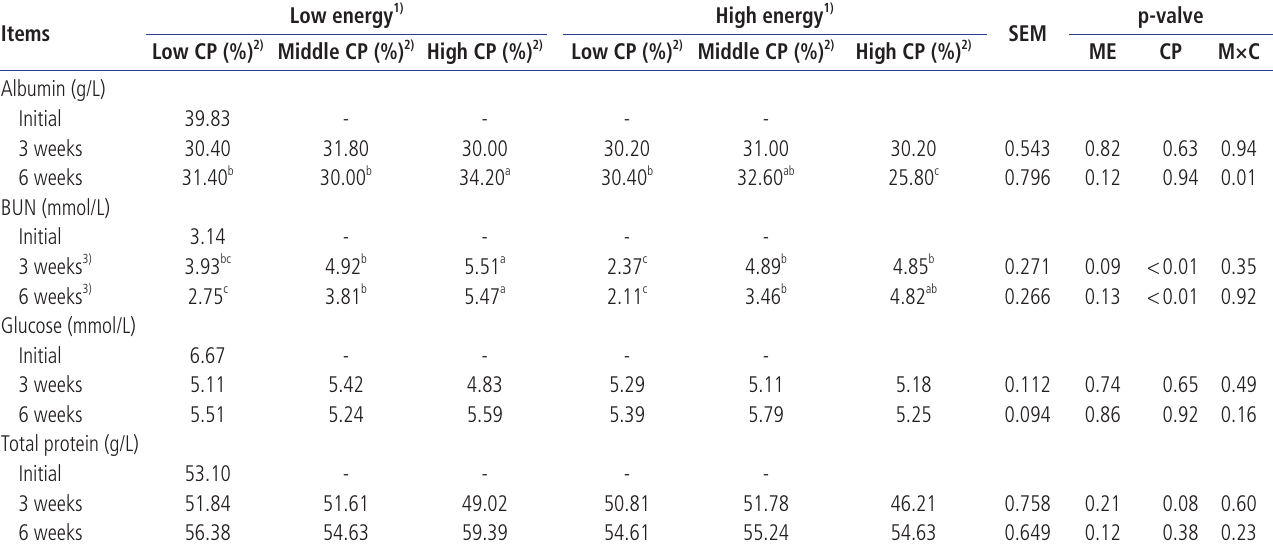
Table 4. Effects of dietary energy and crude protein levels on blood profiles in weaning pigs